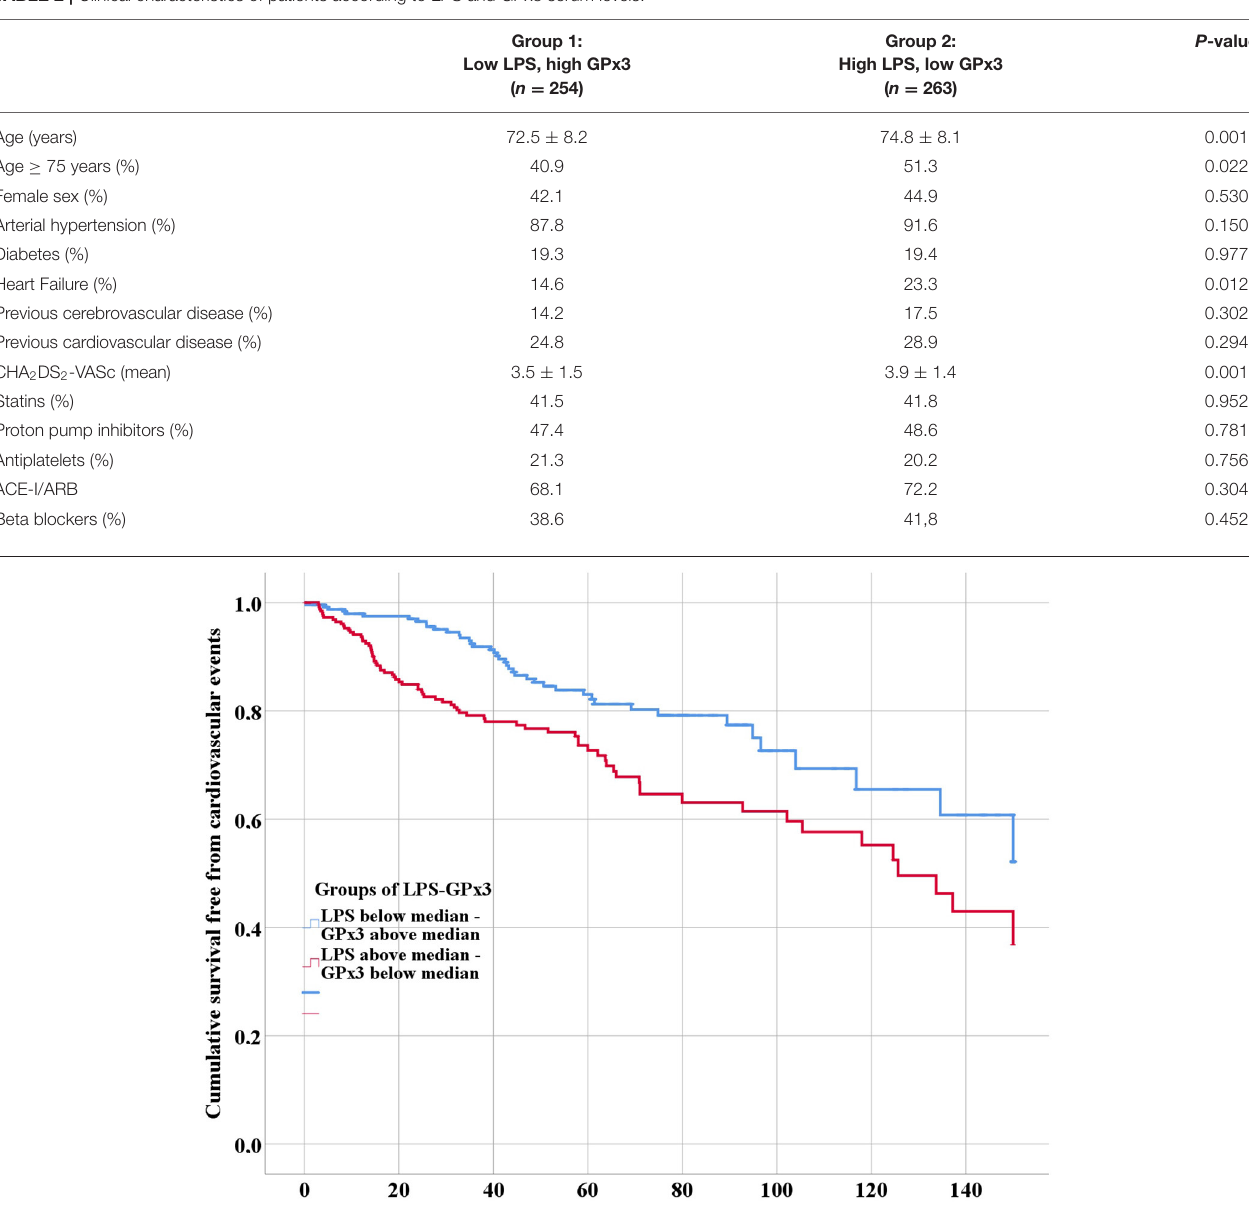
TABLE 2 | Clinical characteristics of patients according to LPS and GPx3 serum levels.